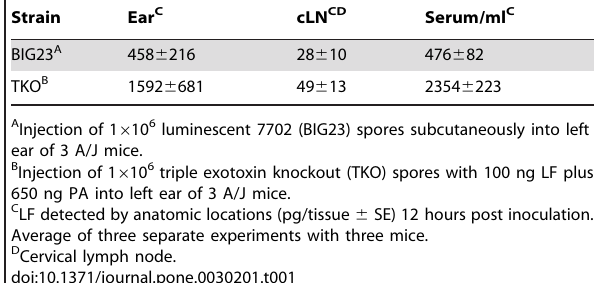
Table 1. Lethal Factor is measurable in the ear, draining cervical lymph nodes and serum at the time of debridement 12 hours after spore inoculation.